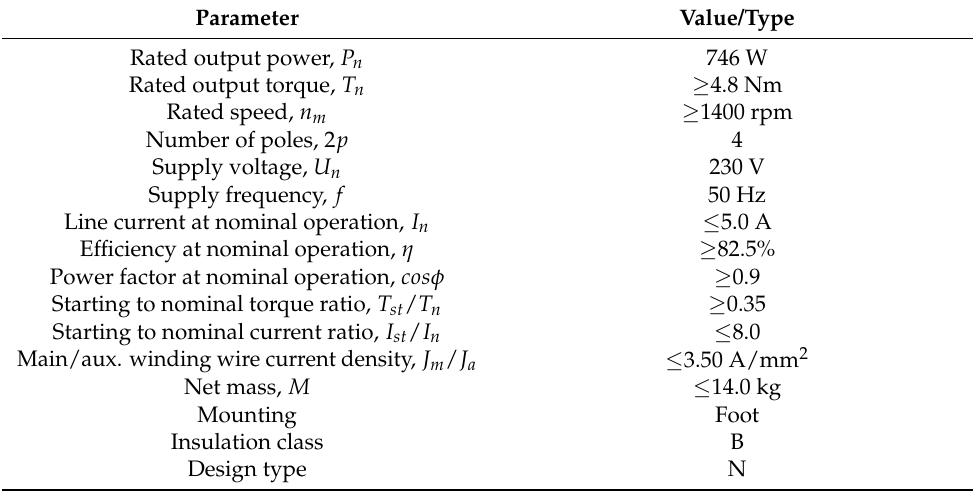
Table 1. SPIM’s operational characteristics and applied constraints.